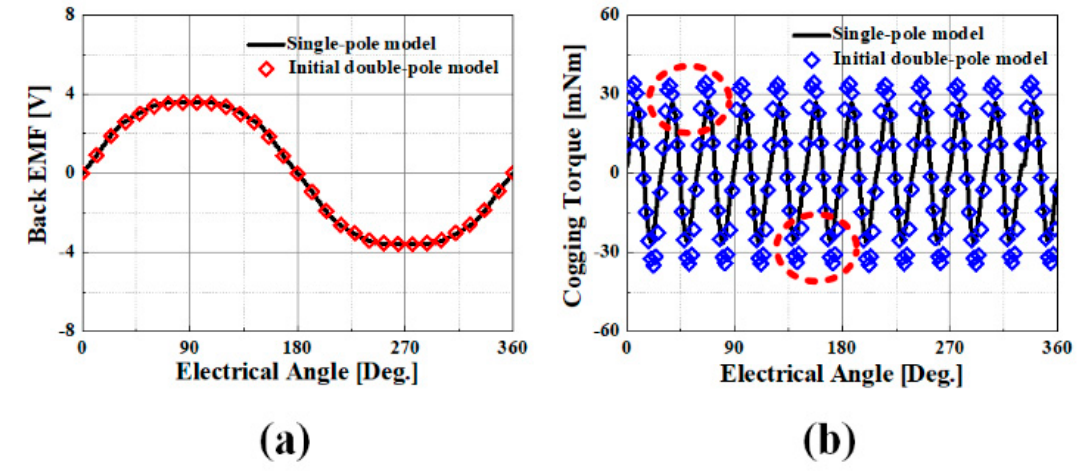
Figure 4. ( a ) PM offset and ( b ) relationship of the PM offset length and PM volume in the double- pole PM.